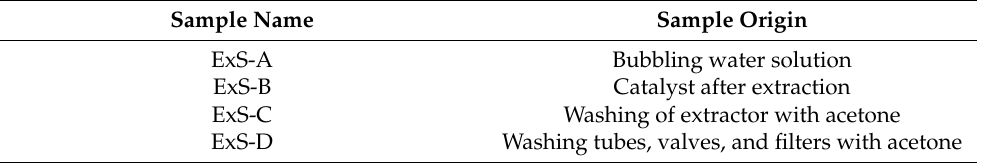
Figure 9. Scheme of screening experiment apparatus. Table 6. Sample nomenclature for the screening experiments.